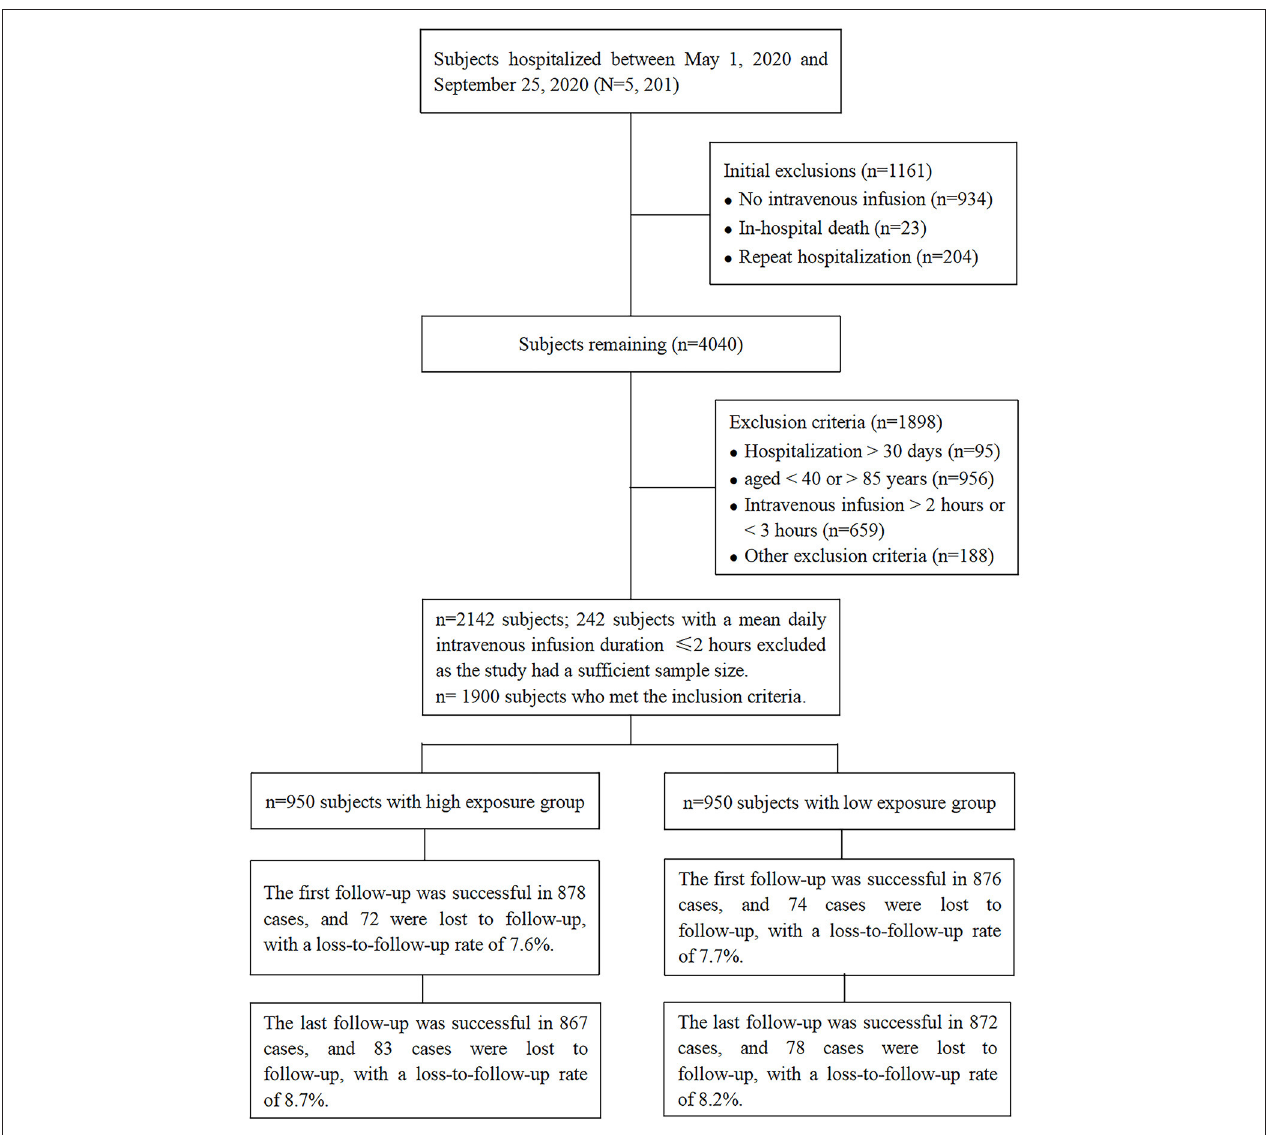
FIGURE 1 | Study flow